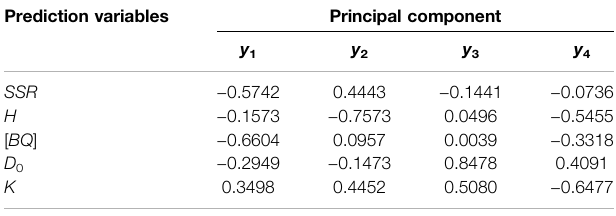
TABLE 6 | The coef fi cient matrix of principal components. Prediction variables